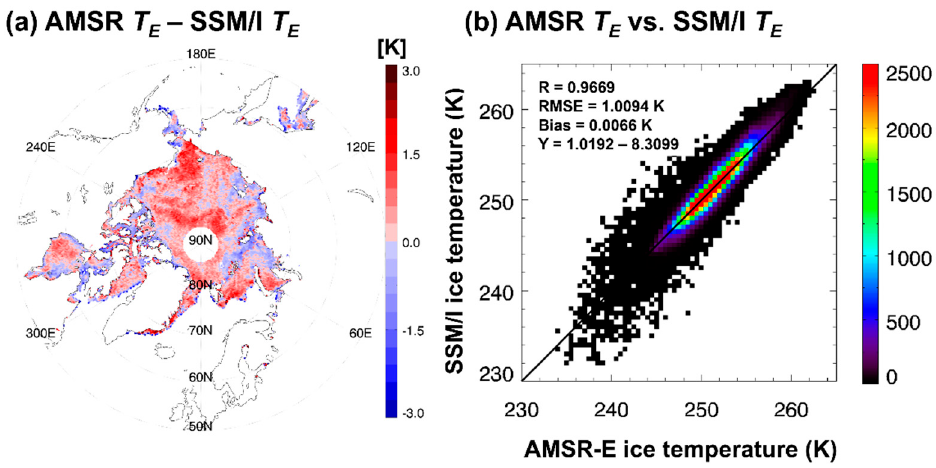
Figure 6. ( a ) Geographical distributions of difference between AMSR-E 6.9 GHz and SSM/I 19.4 GHz-retrieved sea ice temperature for 1 January 2004. ( b ) Scatterplot between two temperatures for January 2004 with bin size of 0.4 K for both axes. Statistics are provided in the scatterplot.